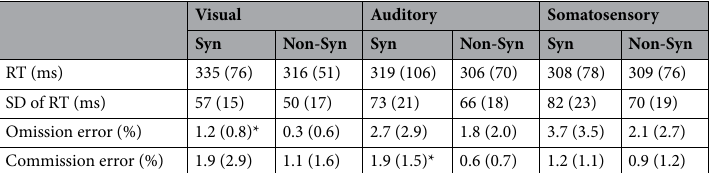
Table 2. Behavioral data during visual, auditory, and somatosensory Go/No-go paradigms in synesthete and non-synesthete groups. Data are expressed as means (SDs). Syn = Synesthete; Non-syn = Non-synesthete. RT = reaction time. SD = standard deviation. Mann–Whitney test showed significant difference between groups as *p <